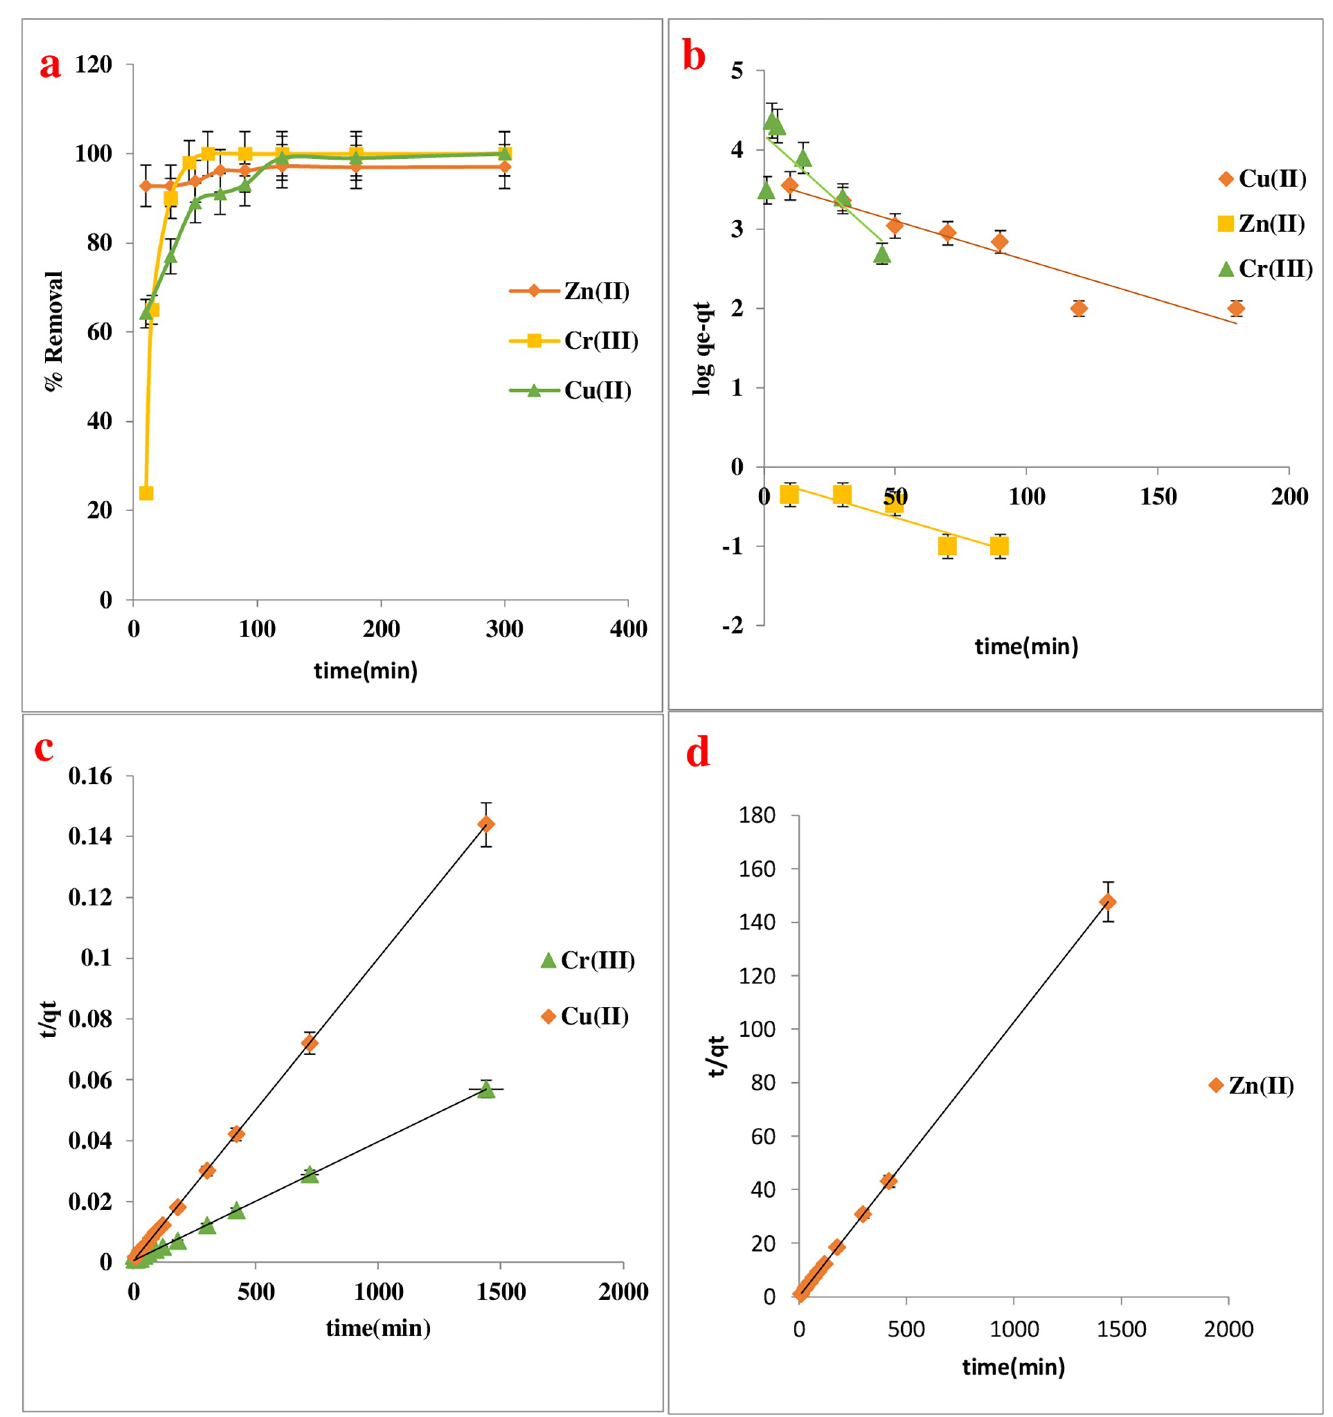
Fig 6. (a) The effect of contact time on the adsorption of Cu(II), Zn(II), and Cr(III) by Imine, (b)Pseudo-1 st order adsorption onto Imine, (c) Pseudo-2 nd order of Cu(II) and Cr(III) onto Imine, and (d) Pseudo-2 nd order for Zn(II) onto Imine.